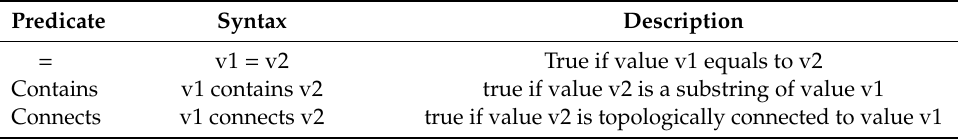
Table 2. Predicates reused from SPARQL for the inspection